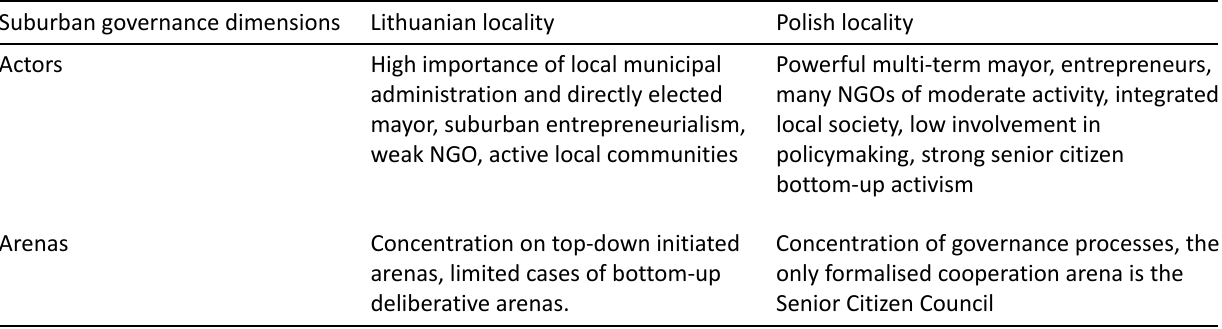
Table 2. Actors and arenas—the main characteristics of the case studies. Suburban governance